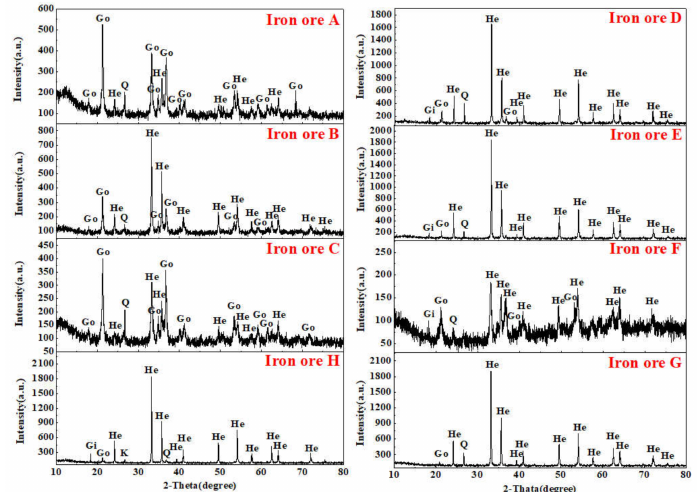
Figure A1. X-ray di ff raction patterns of iron ores (Go-Goethite, He-Hematite, Q-Quartz, Gi-Gibbsite,